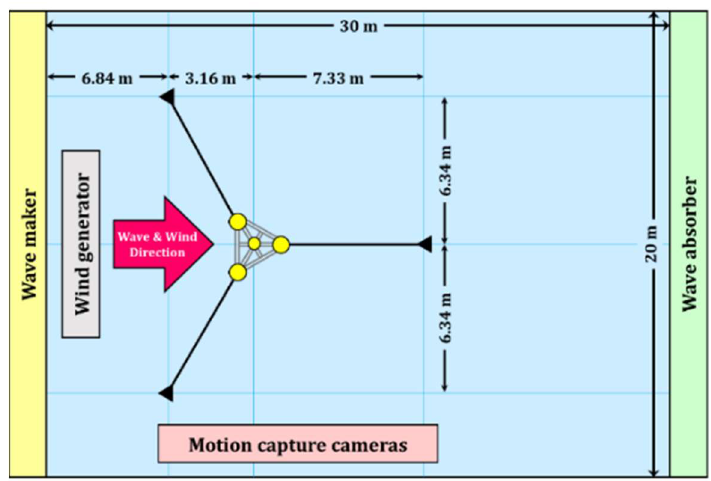
Figure 3. Model test arrangement.